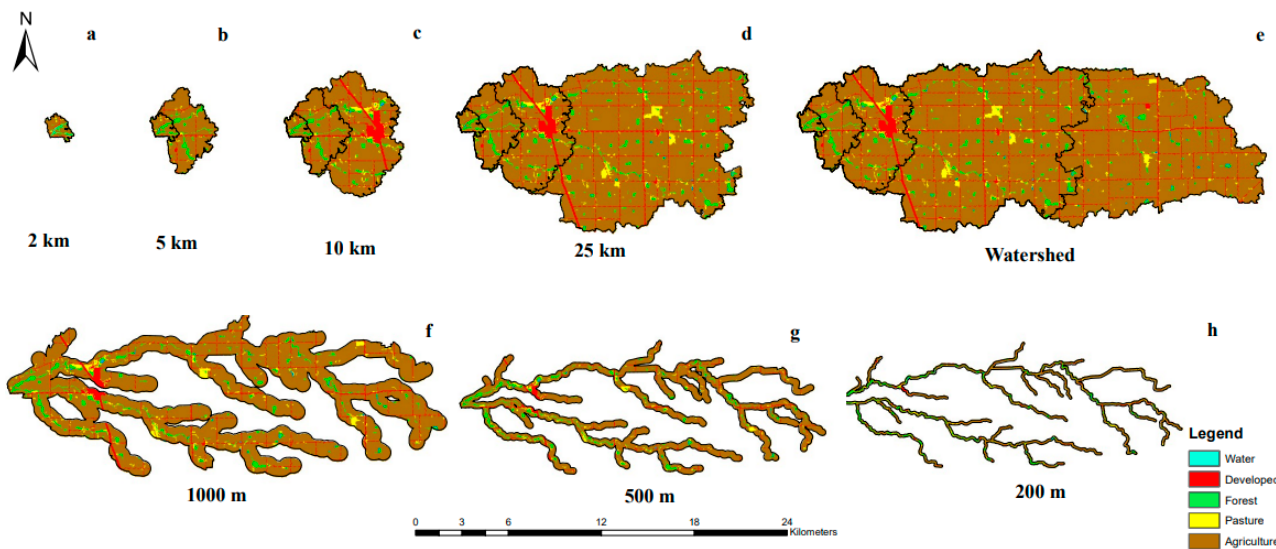
Figure 2. Diagram of some spatial scales including ( a – d ) reach from the outlet, ( e ) entire watershed, and ( f – h ) riparian buffers for watershed WAW030_0022. Table 1. Land use percentages [45] in 2001 for the study watersheds at the water quality stations.